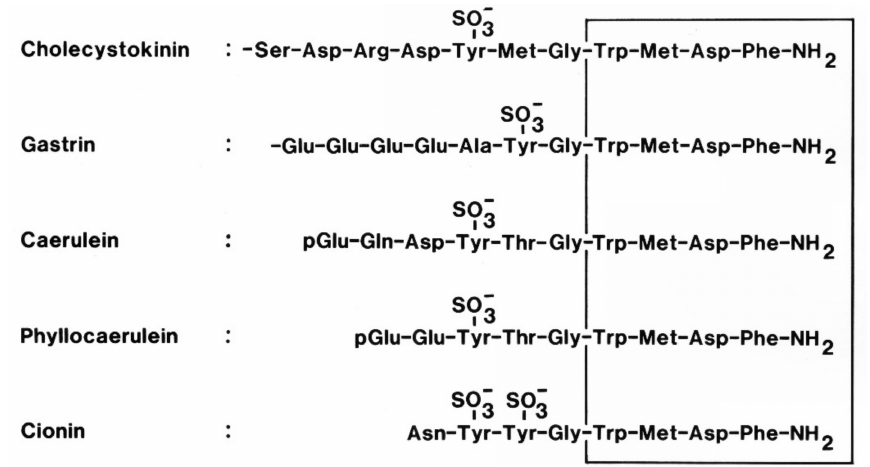
Figure 1. The C-terminal amino acid sequences of members of the cholecystokinin